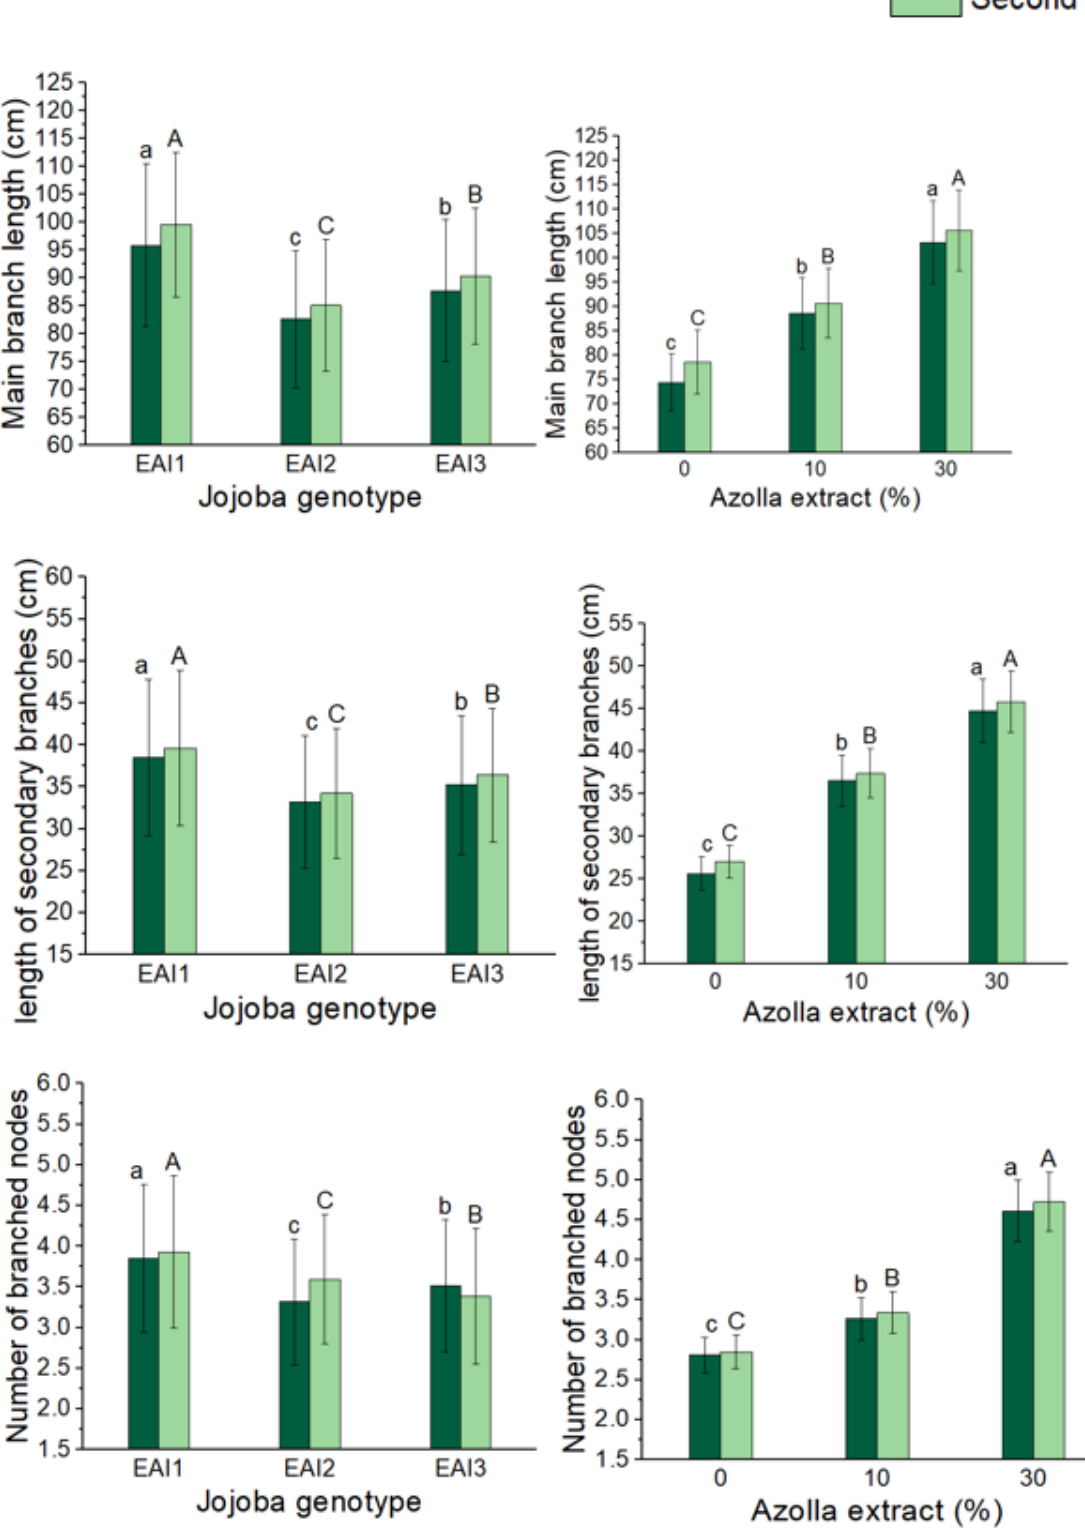
Figure 1. In both seasons, the mean values of main branch length (cm), secondary branch length (cm), and the number of branched nodes of jojoba shrubs were modified by plant genotypes and foliar application of Azolla filiculoides Lam. plant extract respectively. The data are expressed as a mean value ± SE. At the 0.05 level, bars with identical letters are not significant.